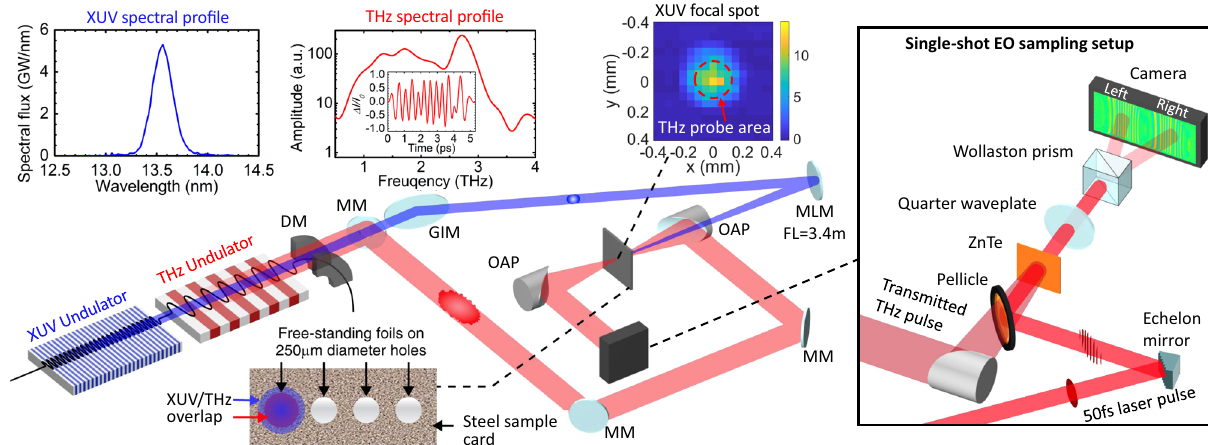
Fig. 1 The experimental setup to measure terahertz (THz) transmission through free-standing gold foils excited by extreme ultraviolet (XUV) pulses. The XUV (13.6 nm peak wavelength) and multicycle THz (2.8 THz peak frequency) pulses are generated with two individual undulators using the same electron bunch at ~680 MeV kinetic energy 19,21 . While the residual electrons are bent-off by a dumping magnets (DM), the two photon beams are separated by a metallic mirror (MM) with a through-hole at its center, i.e., the XUV pulses transmit through the hole and the major part of the THz radiation is re fl ected. After transporting with multiple grazing incidence mirrors (GIM), the XUV pulses are focused onto free-standing gold foils by a near- normal incidence Mo/Si multilayer spherical mirror of 3.4 m focal length. The gold foils are mounted on a steel sample card with 250 μ m diameter holes, and the XUV pulses are de-focused to a focal spot of 255 μ m × 225 μ m FWHM on target. The THz pulses are transported by metallic mirrors before focusing onto the target by a 2 ″ diameter, f /1 off-axis parabolic (OAP) mirror. After transmitting through the sample, the THz pulses are collimated by another OAP, and the E - fi eld amplitude is measured by single-shot electro-optic (EO) sampling 23,24 using a 0.5 mm-thick ZnTe crystal as shown in the inset on the